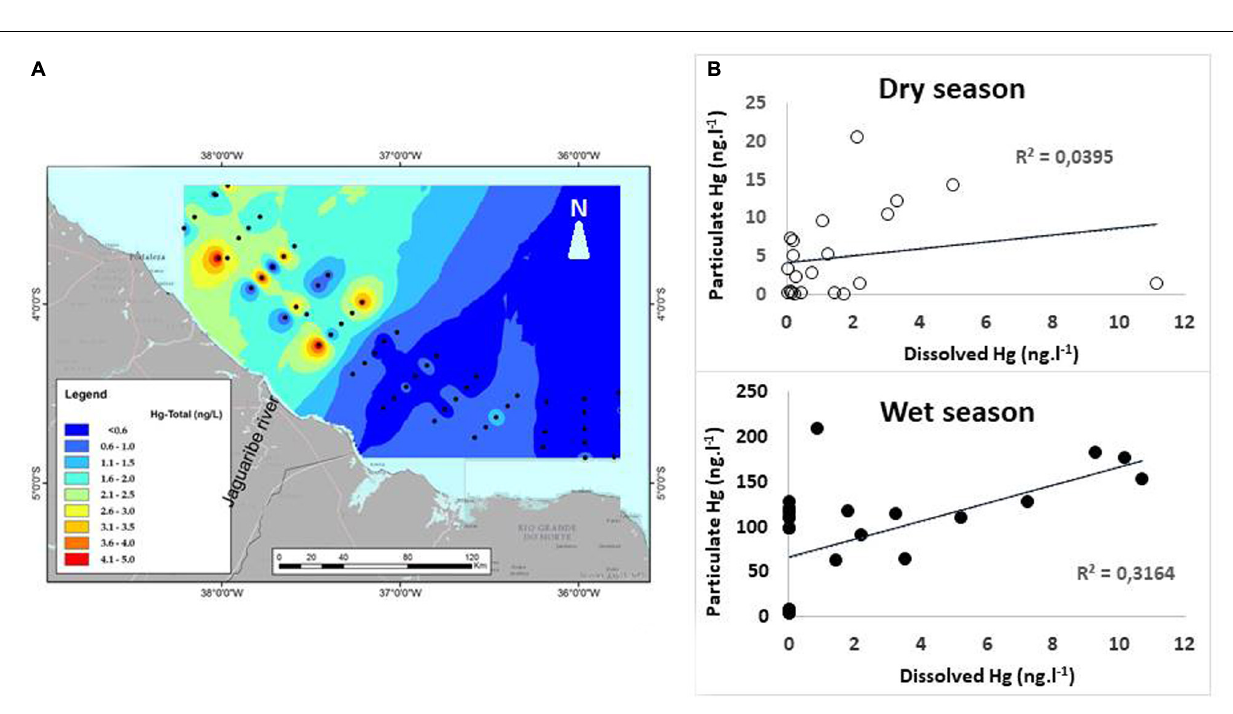
FIGURE 3 | (A) Total Hg distribution in continental shelf surface water off the semiarid coast of NE Brazil. Hot spots of Hg concentrations are clearly shown off the Jaguaribe River Estuary, similar to the hot spot off Fortaleza City, a major contributor of anthropogenic Hg. (B) Relationship between dissolved and particulate Hg in waters off the Jaguaribe River in the dry and wet